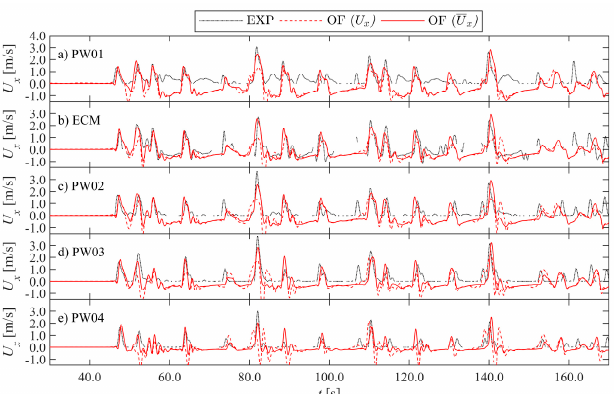
Figure 4. Comparison of the η time series at all sensor locations ( a – j ), including η LW in ( a – f ) (bold lines). The zero-reference is the SWL for ( a – f ) and the promenade bottom for ( g – j ).